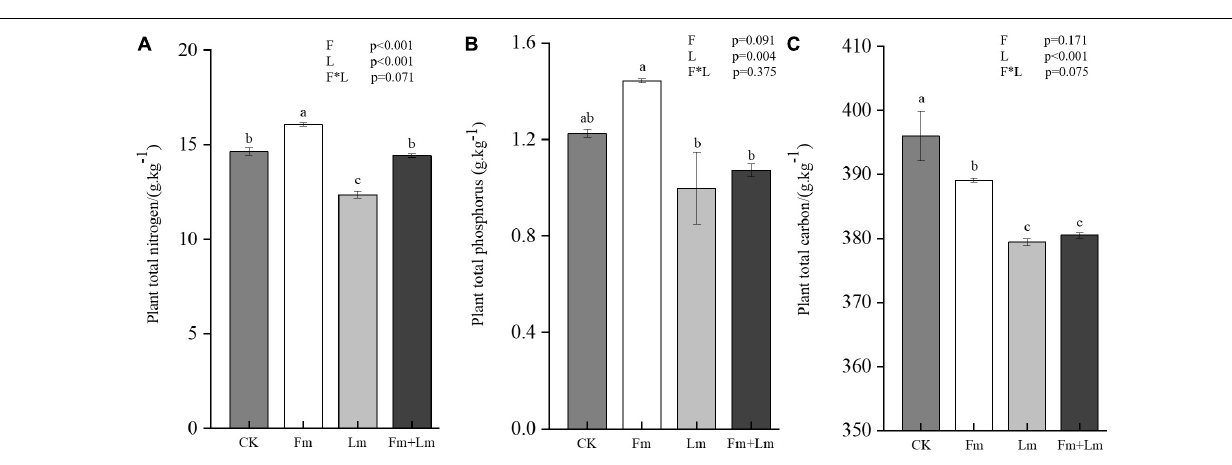
FIGURE 3 | The effects of different treatments on plant nutrition. Total nitrogen, (A) total phosphorus, (B) and total carbon (C) of plant leaves. Four treatments (CK, Fm, Lm, and Fm + Lm) were established as described in Figure 2 . Values are means ± standard error. P -values for inoculation and insect feeding effects were based on two-way ANOVA. Mean values followed by the same letter do not differ significantly at P ≤ 0.05 by